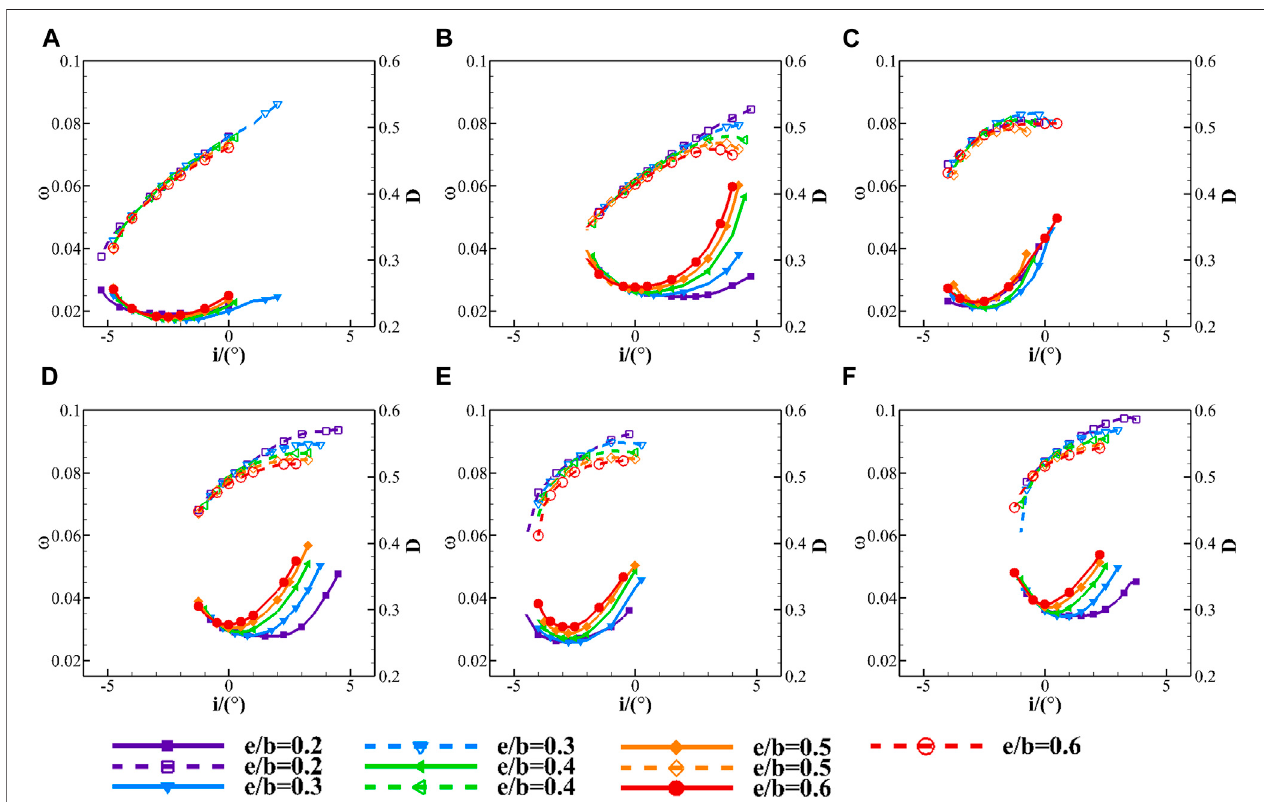
FIGURE9| In fl uenceofmaximumthicknesslocationsonincidencecharacteristicsoftotalpressurelosscoef fi cientanddiffusionfactor (A) θ (cid:1) 40 ° , σ (cid:1) 1.25; (B) θ (cid:1) 40 ° , σ (cid:1) 2.05; (C) θ (cid:1) 44 ° , σ (cid:1) 1.25; (D) θ (cid:1) 44 ° , σ (cid:1) 2.05; (E) θ (cid:1) 46 ° , σ (cid:1) 1.25; (F) θ (cid:1) 46 ° , σ (cid:1)